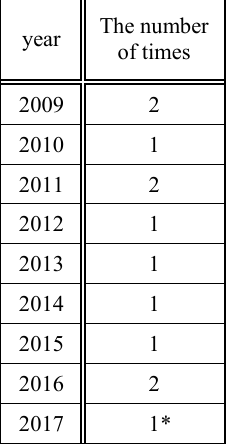
Table 1. The number of times of training sessions of in-service teachers of elementary and junior high